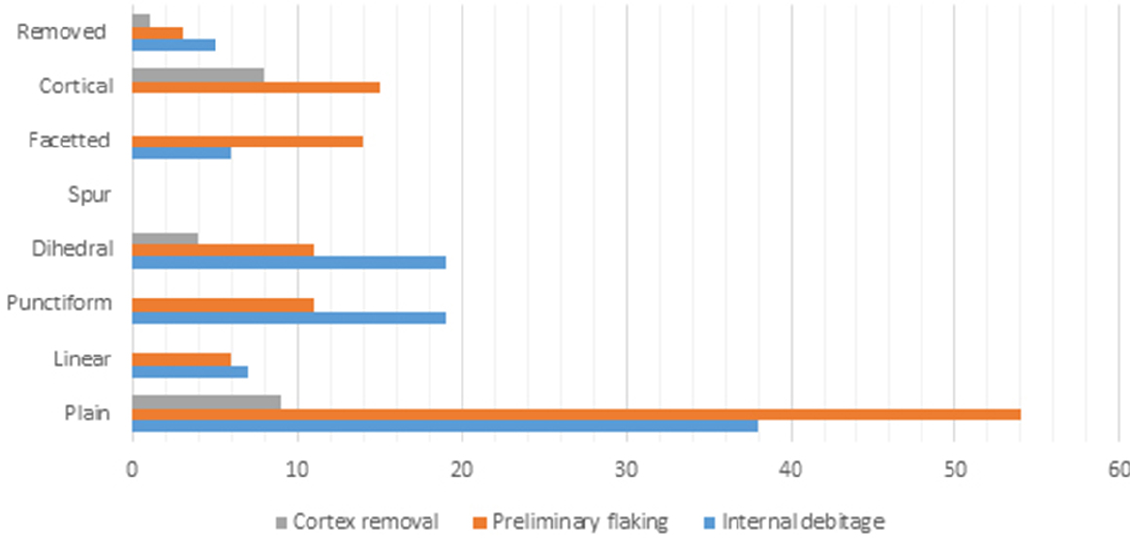
Figure 4. Corresponding overall percentages from